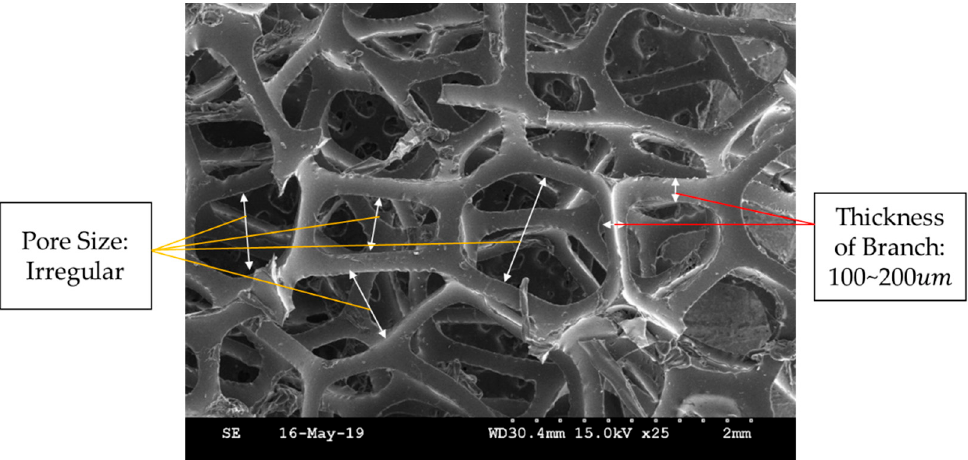
Figure 4. SEM photo of polyurethane foam.